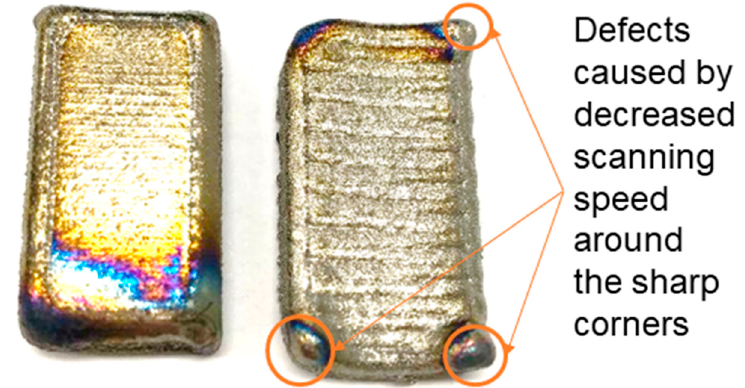
Figure 5. Bulk samples manufactured by LMD using di ff erent scanning parameters.